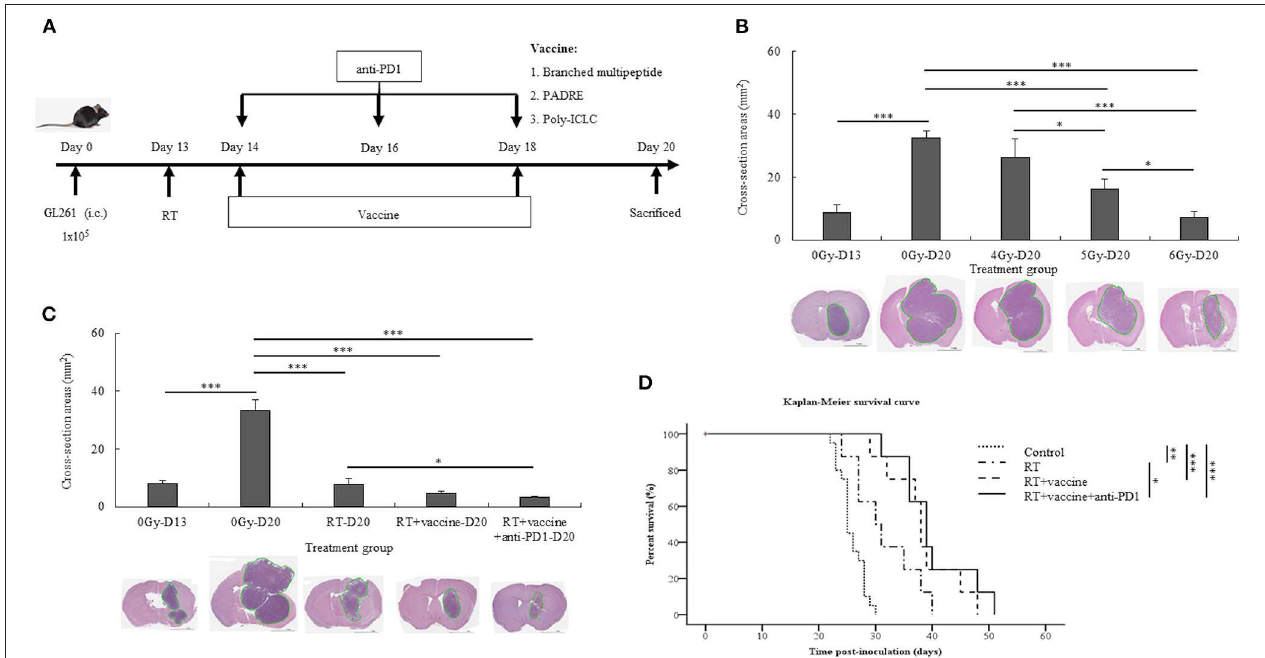
FIGURE 2 | Experimental treatment schedule, and therapeutic effects of combination treatment. Schema outlining treatments used in the experiments (A) . Brain tumor size with and without radiation relative to the different radiation dose treatment (4, 5, and 6Gy) was estimated with H&E staining (B) . The brain tumor sizes before (day 13) and after treatment (day 20) with different combinations, such as RT, RT plus vaccine, and RT plus vaccine and anti-PD1, were confirmed by H&E staining (C) . The Kaplan-Meier survival curves used to estimate the survival of the mouse tumor model according to the different treatment combinations in GL261 glioma-bearing mice, such as RT ( n = 8), RT plus vaccine ( n = 8), and RT plus vaccine and anti-PD1 ( n = 8), compared with the untreated control ( n = 20) (D) . Data are summarized by bar charts as the mean ± standard deviation (SD). All data are represented as the mean of two independent experiments. Control: no treatment group; RT, radiation therapy; vaccine, branched multipeptide plus PADRE and poly-ICLC; * p < 0.05; ** p < 0.01; and *** p < 0.001.